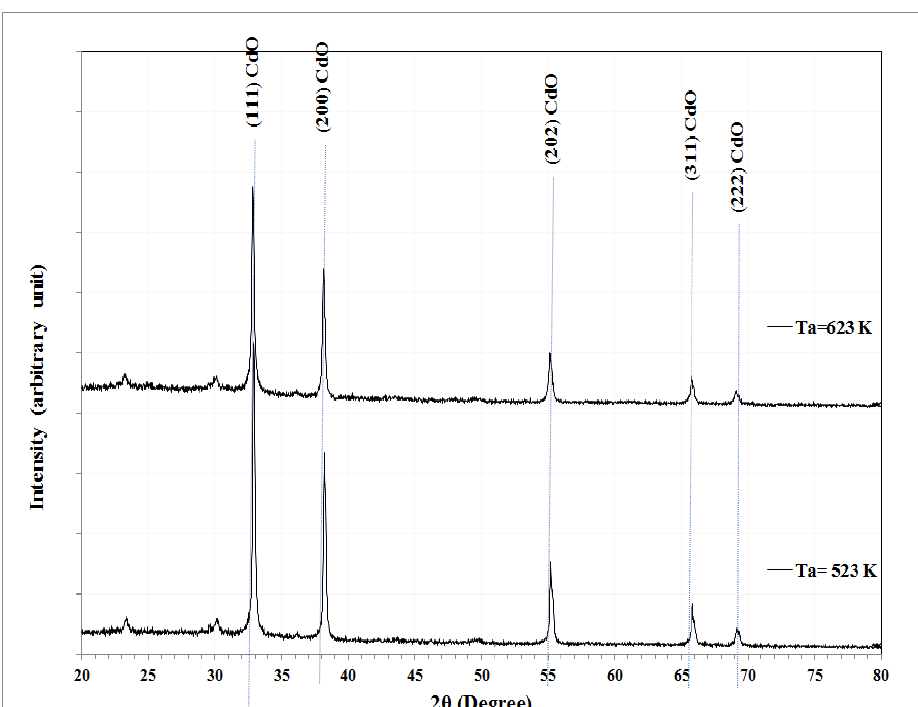
Fig. 2: X-ray diffraction curves CdO thin films deposited by voltage (1200) Volt at (523 and 623) K.